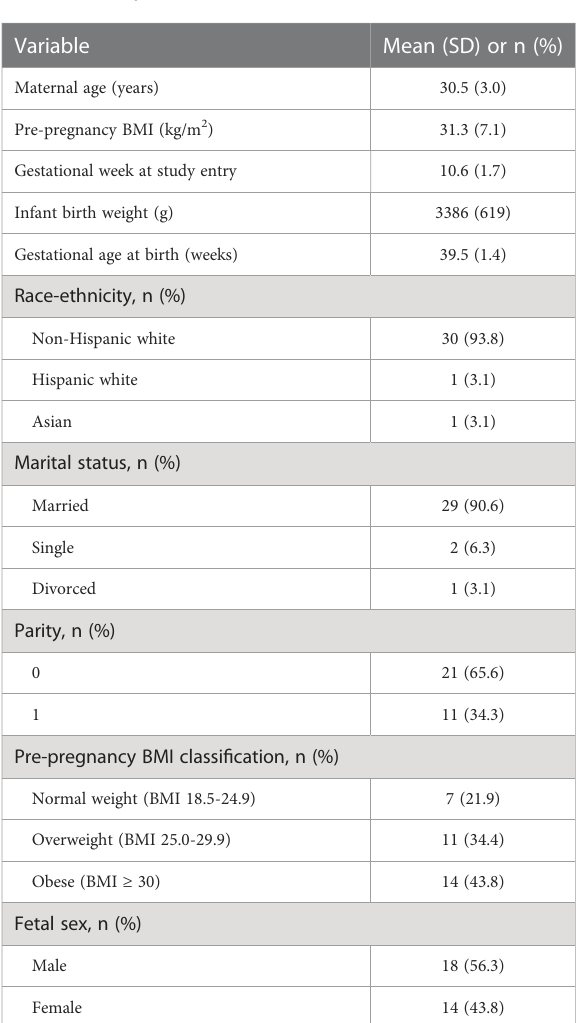
TABLE 1 Participant characteristics